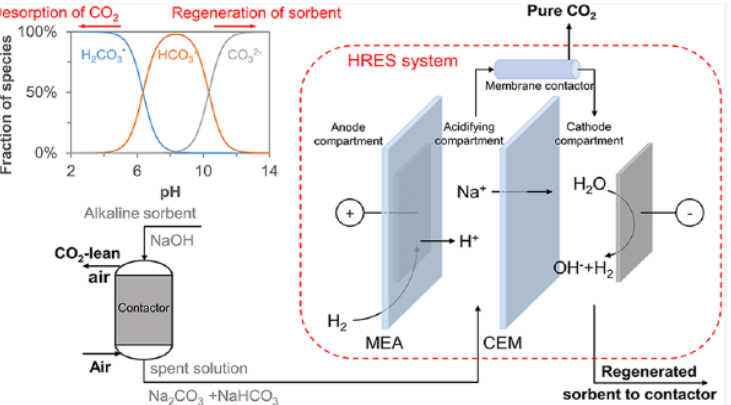
Figure 10. Scheme of the experimental process (MEA = membrane electrode assembly, CEM = cation exchange membrane). Reproduced under the ACS AuthorChoice/Editors’ Choice via CC-BY-NC-ND Usage Agreement [121].